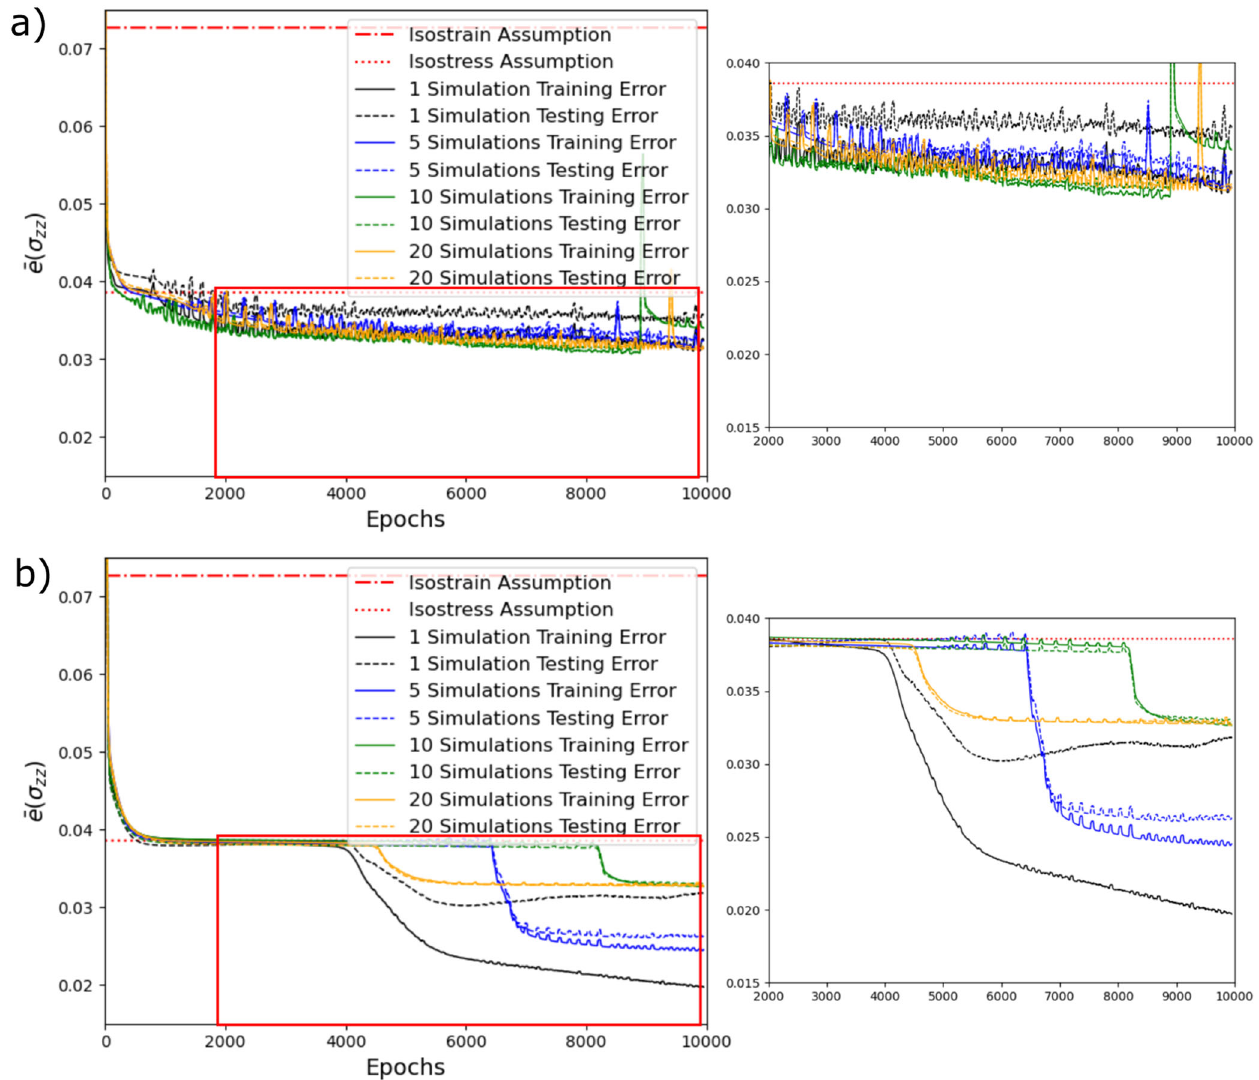
Fig. 2 Learning rates of Ti-7Al grain-scale elastic response using various numbers of CEFEM simulations for training and testing. Insets show a magni fi ed view of the learning rate at larger epochs. a Learning rates using the directional modulus E ( r ) as a nodal feature. b Learning rates using the lattice orientation (components of the Rodrigues vector r ) as nodal